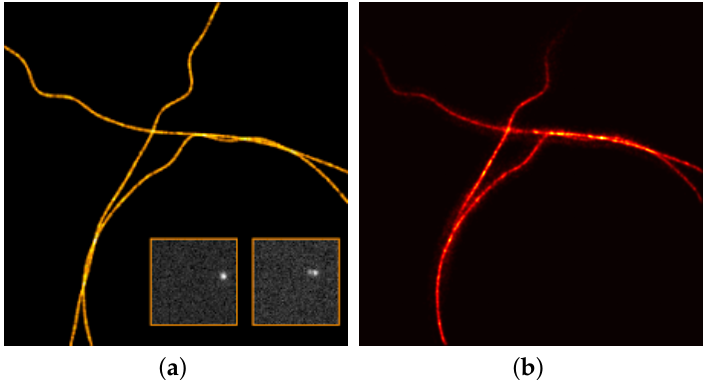
Figure 9. ( a ) Ground-truth tubulins, two excerpts of the stack in the square below: convolution + all noise described before; ( b ) reconstructed measure by Sliding Frank-Wolfe visualised through Gaussian kernel with a smaller σ (see